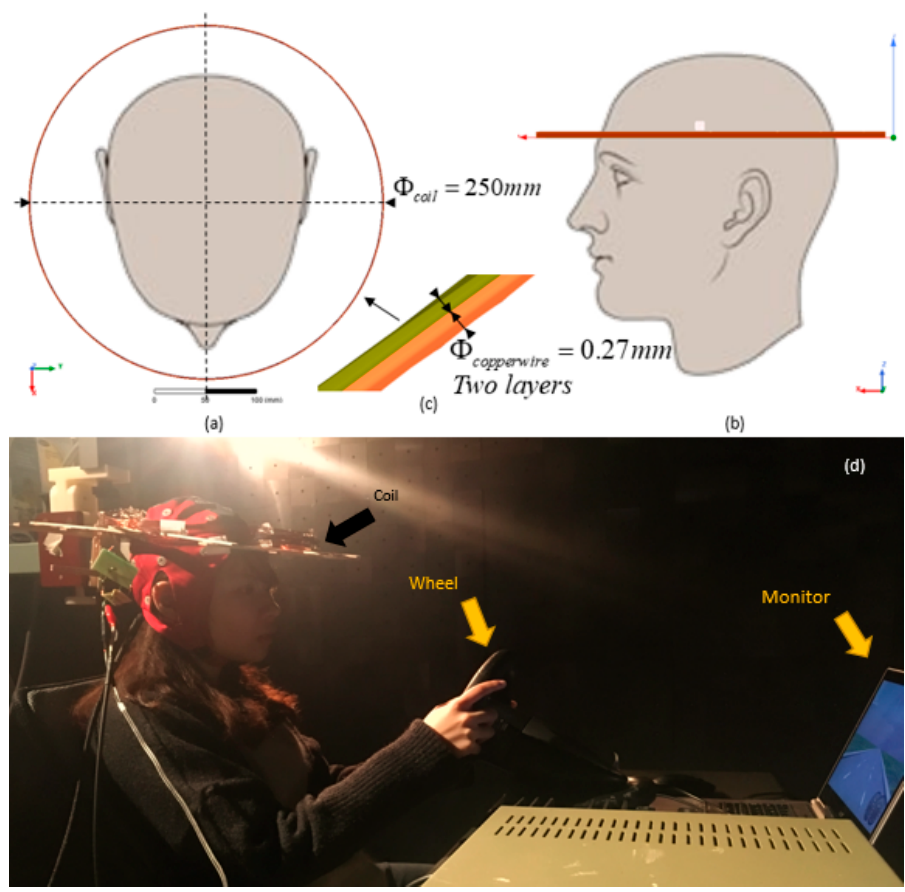
Figure 1. The set-up of the experiment in an anechoic chamber. ( a ) the top view and ( b ) the left view elaborate the relative position between subjects’ head and the coils, respectively; ( c ) elaborates the two-layer structure, as well as the parameter of the coil in the experiment; ( d ) demonstrates the overview of the setting-up of the experiment in the anechoic chamber.